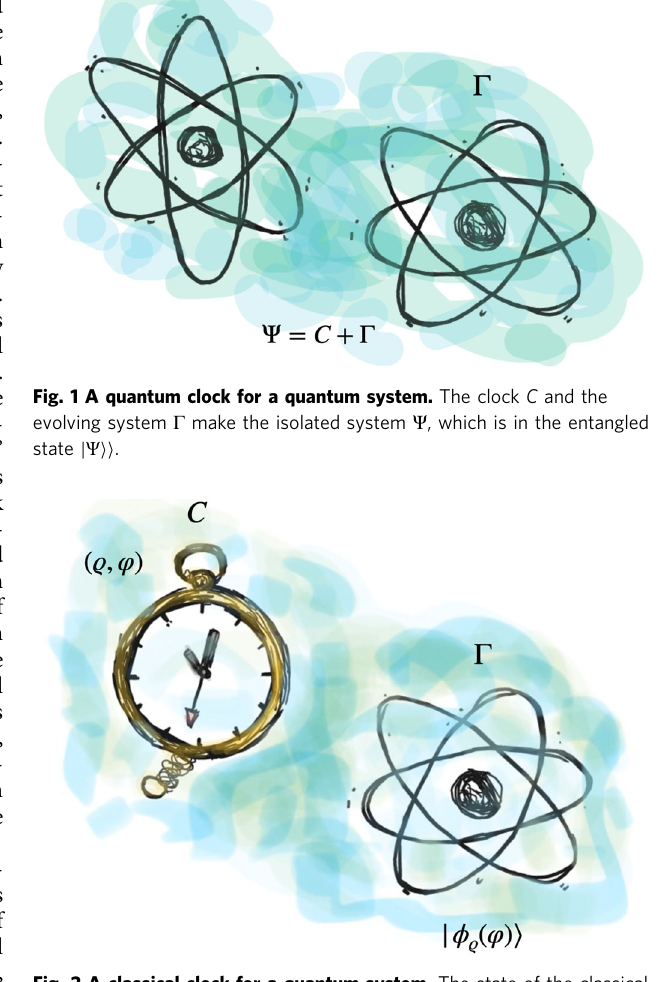
Fig. 2 A classical clock for a quantum system. The state of the classical clock C is identi fi ed by the real variables ϱ and φ , while j ϕ ρ ð φ Þi is the state of the quantum system Γ that parametrically depends on ( ϱ , φ